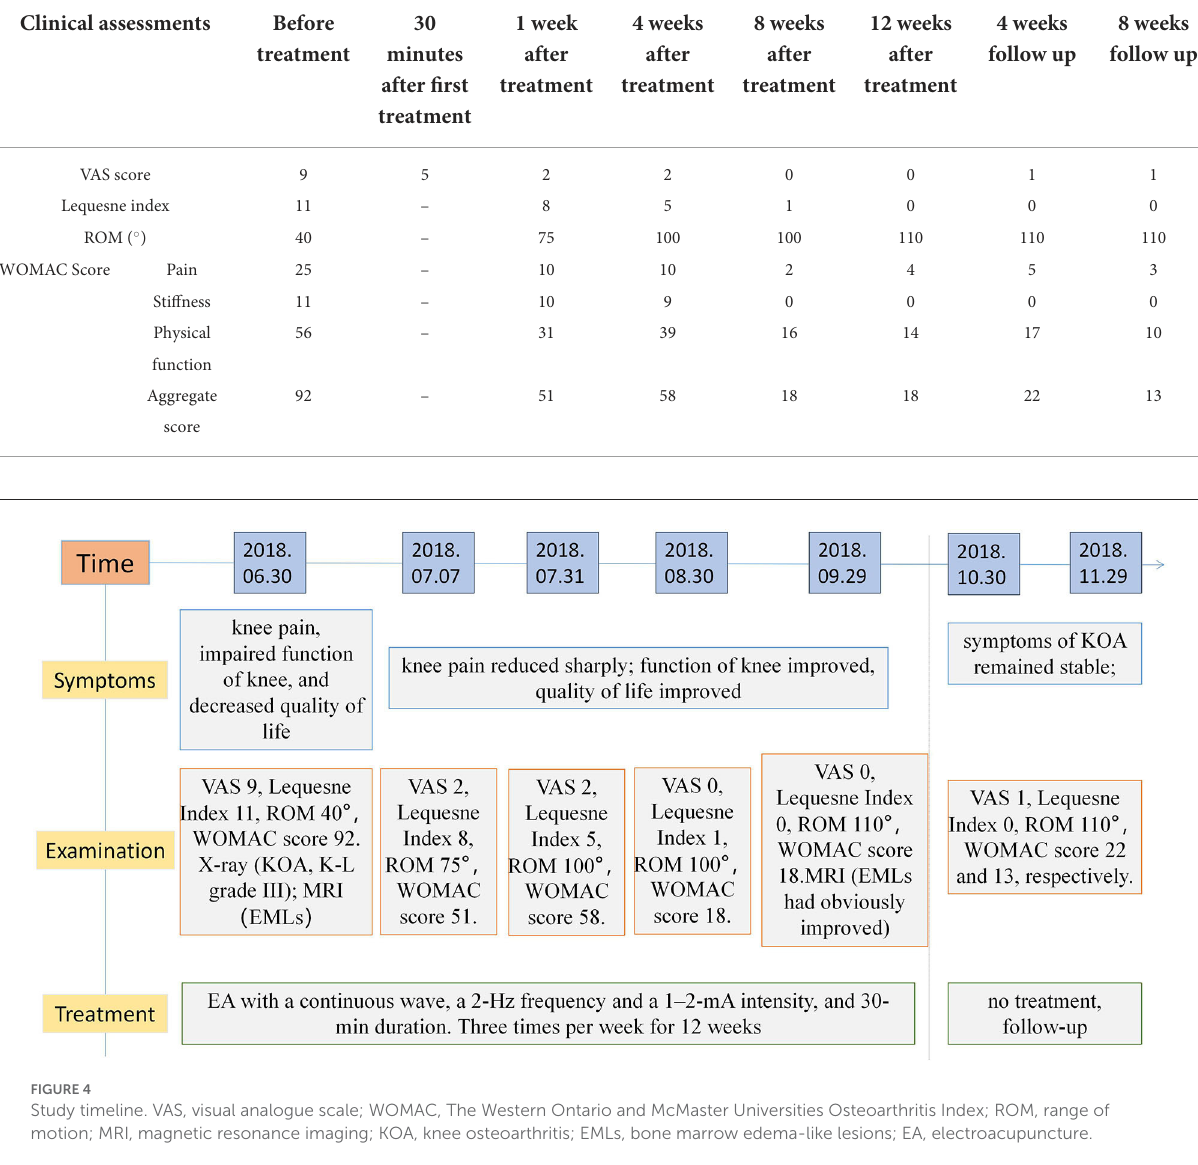
FIGURE4 Study timeline. VAS, visual analogue scale; WOMAC, The Western Ontario and McMaster Universities Osteoarthritis Index; ROM, range of motion; MRI, magnetic resonance imaging; KOA, knee osteoarthritis; EMLs, bone marrow edema-like lesions; EA,